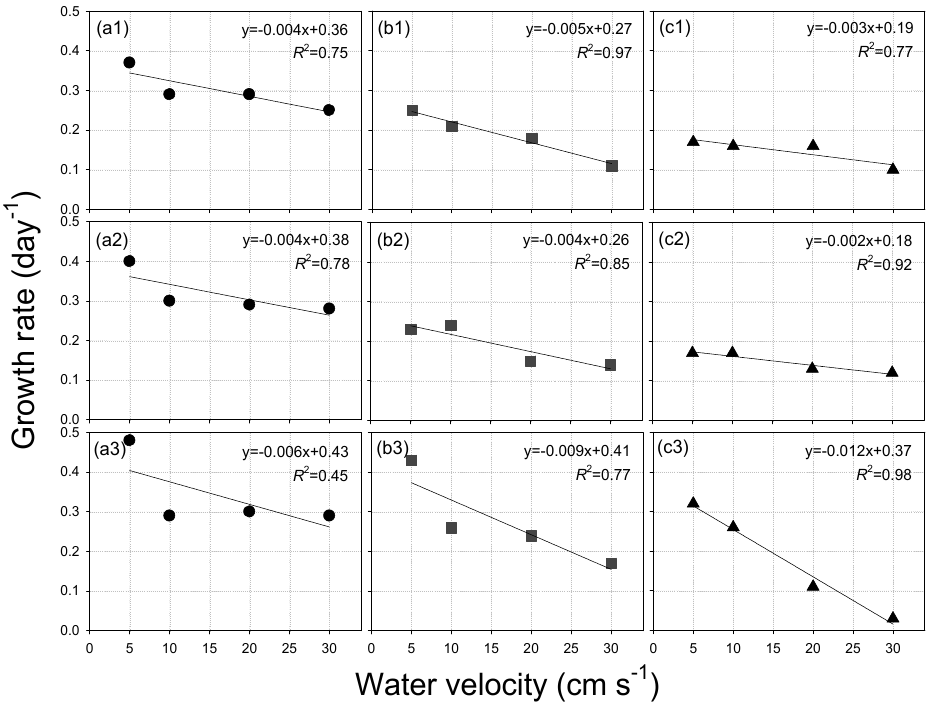
Figure 6 Relationships between water velocity and periphyton growth rate with different water sources and substrata ( a ): MW1; ( b ): HR; (c): BFW; ( 1 : tile; 2 : concrete; 3 : pebble; n =